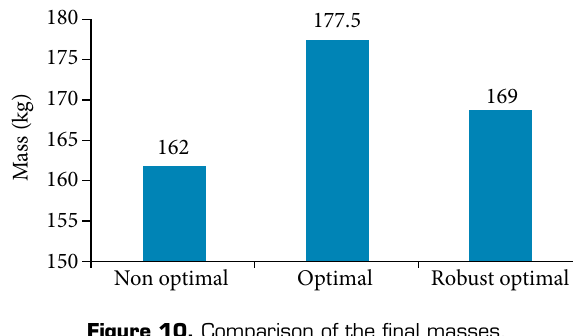
Figure 10. Comparison of the final masses.